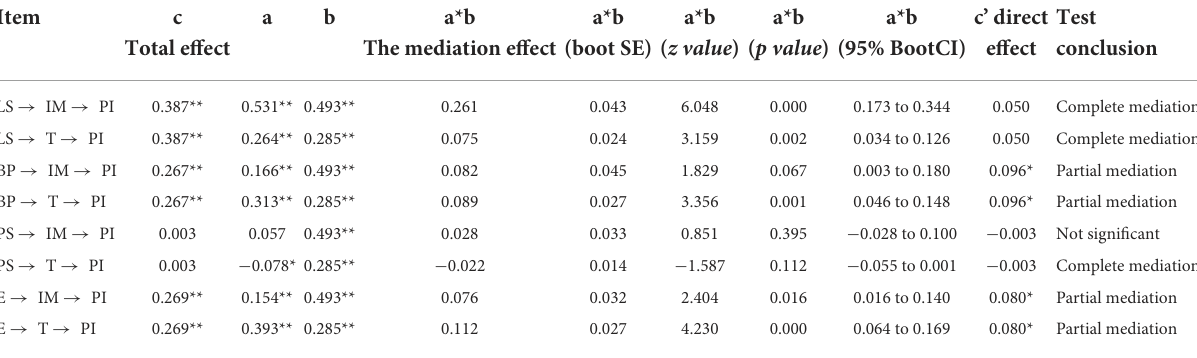
TABLE 3 Summary of mediating effect test